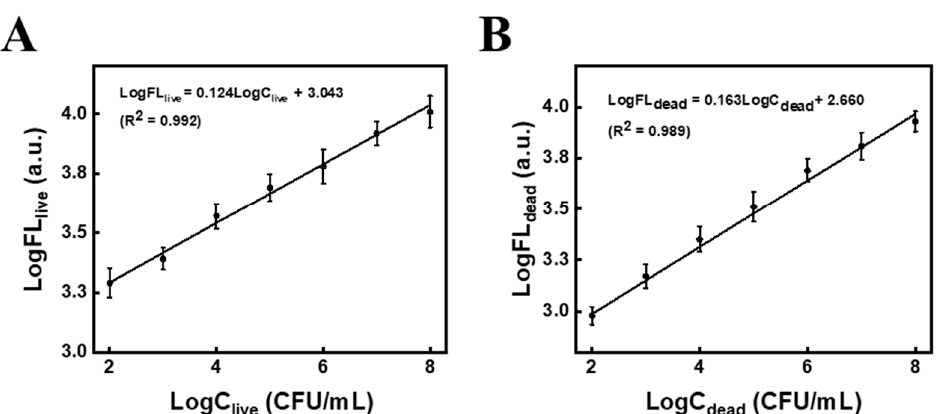
Figure 8. Fluorescence calibration curves at different concentrations of ( A ) live S.T and ( B ) dead S.T. Table 2. Detection of total S.T in real samples by FL ( n = 3).